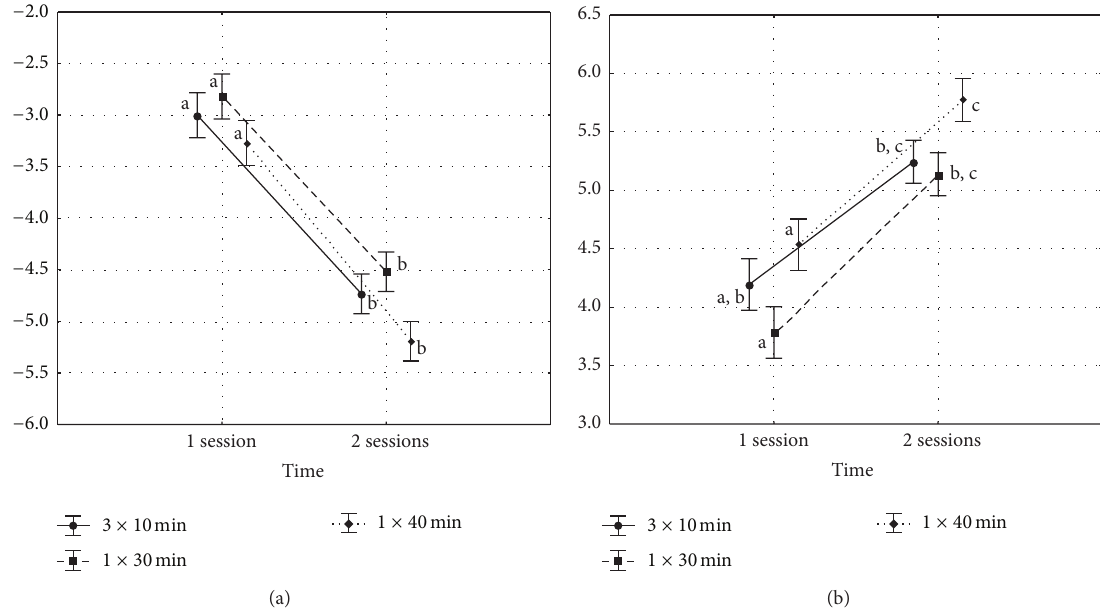
Figure 2: Results of Δ𝑏 (a) and Δ𝐸𝑎𝑏 (b). Vertical bars denote ± standard errors, and sets with the same letters are not significantly different (Tukey’s Test, 𝑃 > 0.05 ).